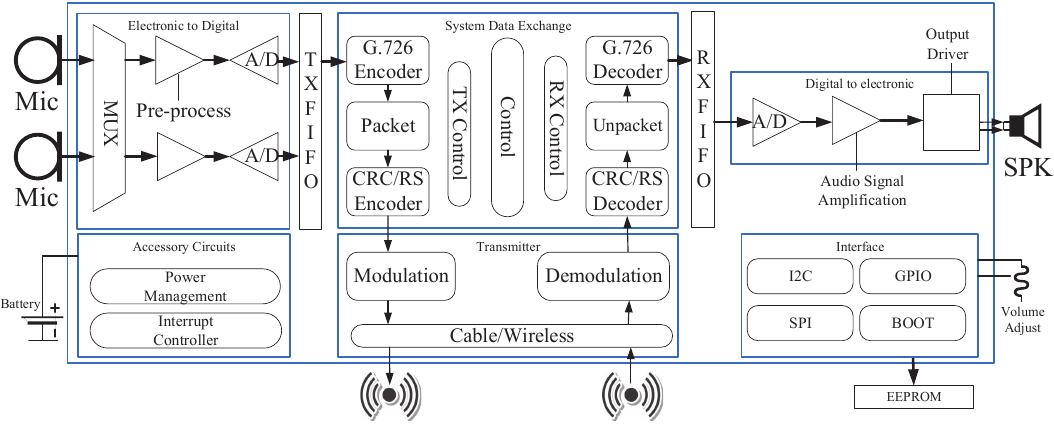
Figure 9. Top-level system block diagram of the